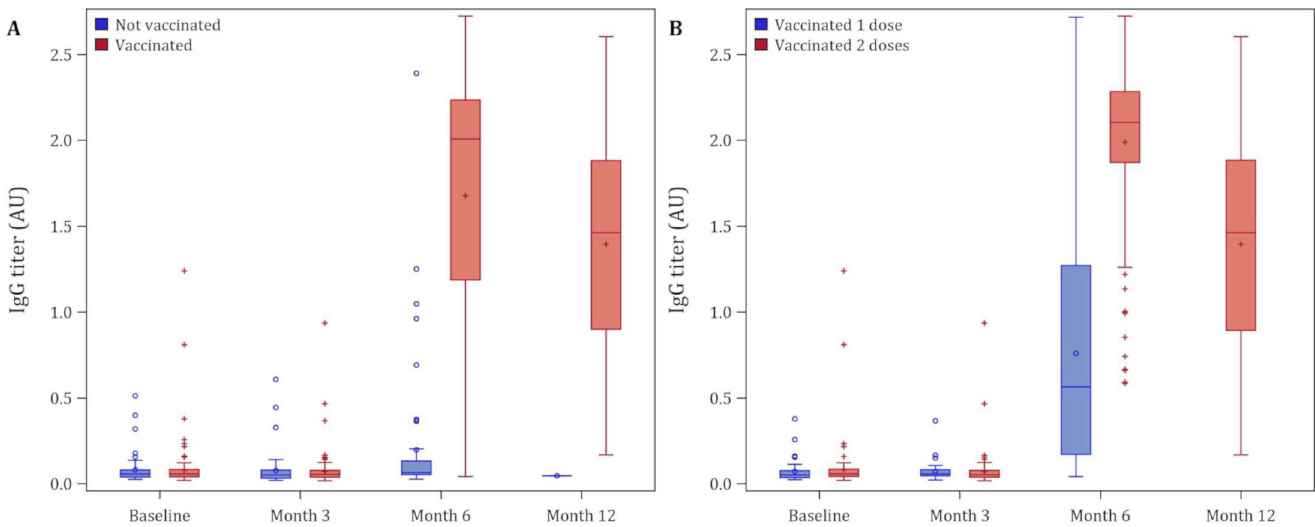
Fig 3. Box plot for participants who got blood tested at baseline, months 3, 6 and 12. (A) All participants; (B) Vaccinated with at least one dose. Legend: The bottom and top edges of the box indicate the IQR, the marker inside the box indicates the mean value, the line inside the box indicates the median value. The upper and lower fences are maximum and minimum values, respectively, points beyond upper and lower fences are